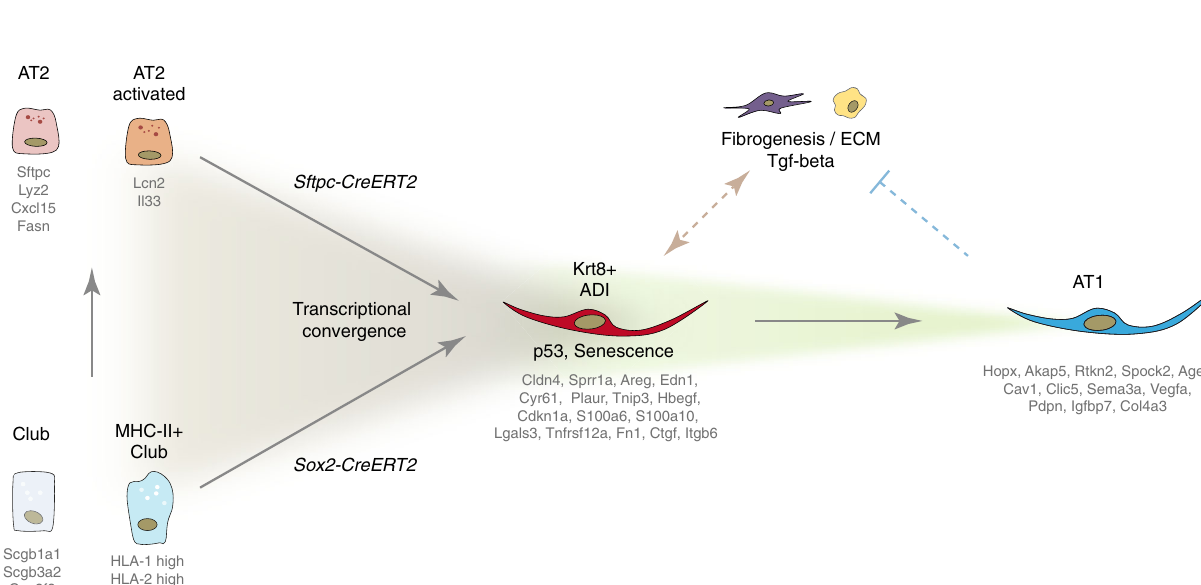
Fig. 10 A revised model of alveolar regeneration. We identify convergence of alveolar and airway stem cells on an injury-induced transitional cell state characterized by a unique transcriptional signature, including high levels of Krt8 expression, that precedes the regeneration of AT1 cells. In this process, stem cells lose cell identity genes, gain speci fi c gene programs including p53 and NFkB target genes, and undergo a drastic change in shape towards a squamous morphology. Krt8 + ADI cells feature a highly distinct connectome of receptor-ligand pairs with endothelial cells, fi broblasts, and macrophages. The Krt8 + ADI cell state persists in models of progressive lung fi brosis and human IPF patients, suggesting that the cell state transitions described in this work are coordinated in space and time by cell intrinsic and tissue niche checkpoints that may be derailed in